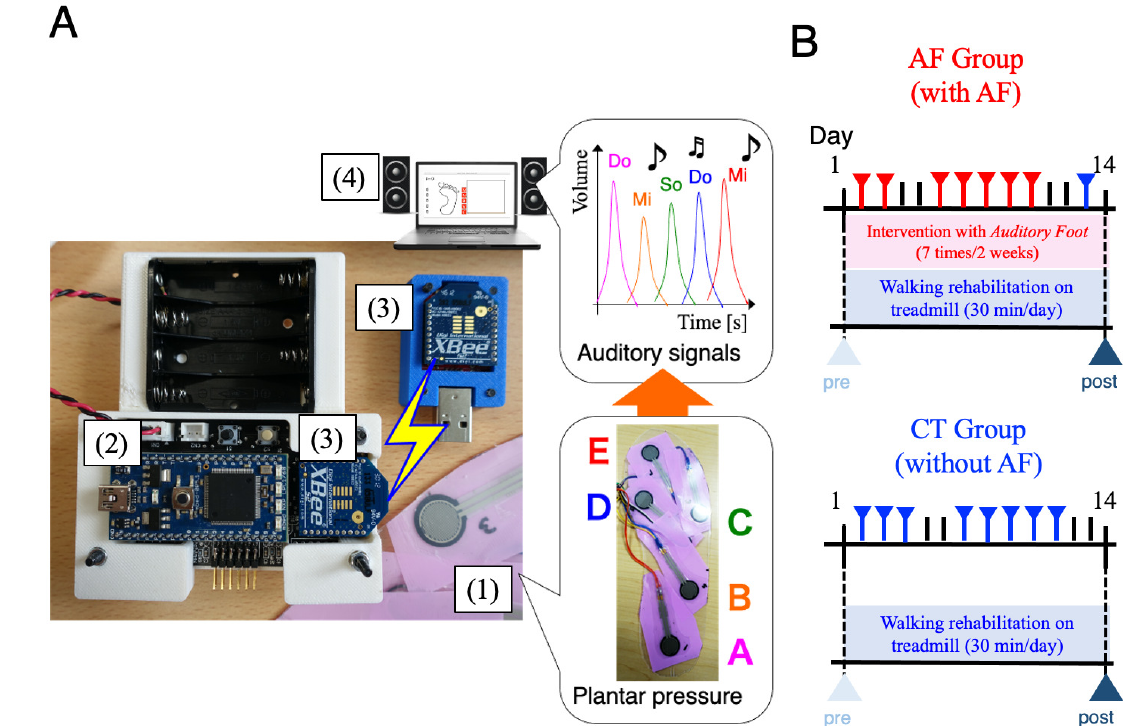
Figure 1. ( A ) Auditory biofeedback prosthesis, called Auditory Foot . Entire system of the sensor prosthesis which consists of four components: (1) pressure sensors (sensory input), (2) a microcomputer (sensor data processing), (3) wireless communication devices (data transportation), and (4) a PC (audio output). ( B ) Experimental design. The patients performed locomotion training (30 min/day) on a treadmill at a comfortable speed for two weeks. The subjects were randomized into two groups: AF group (training with AF) and CT group (training without AF as control). The subject of AF group performed seven rehabilitation sessions with AF during the two weeks. Red markers indicate AF intervention, blue markers indicate normal rehabilitation. The two black lines represent weekend, i.e., hospital was closed. As a buffer for a holiday during the two-week period, the 13th day contained normal walking training for the AF